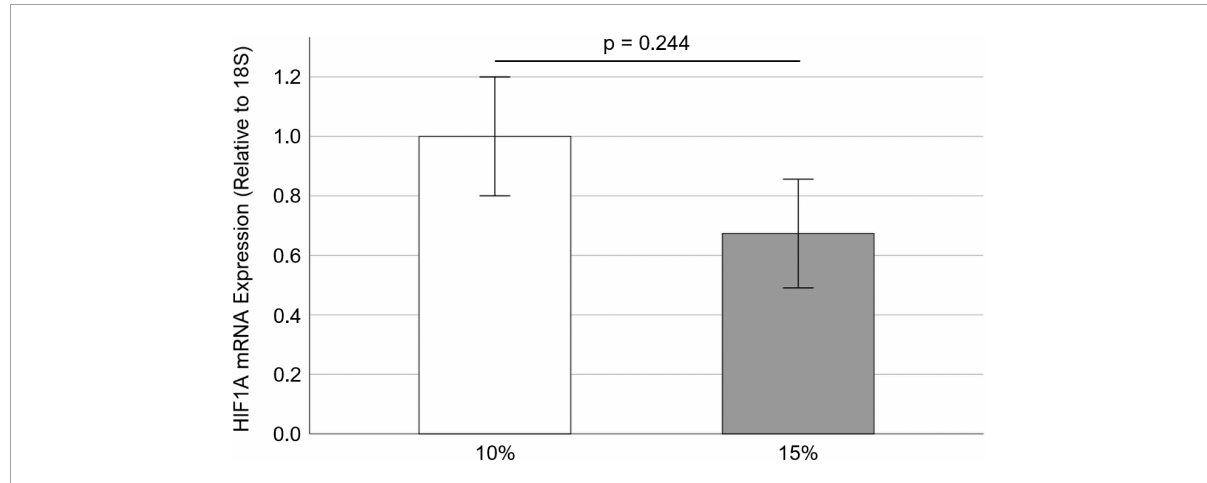
FIGURE5 Effect of cyclic stretch on HIF1A mRNA expression in porcine aortic valve (PAV) leaflets ( n =